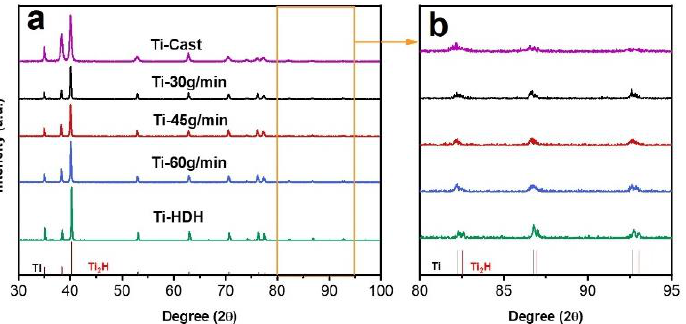
Figure 4. ( a ) XRD pattern of HDH titanium powders before and after radio frequency plasma treatment; ( b ) zoom-in image of the XRD patterns with 2 θ ranging from 80 ◦ to 95 ◦